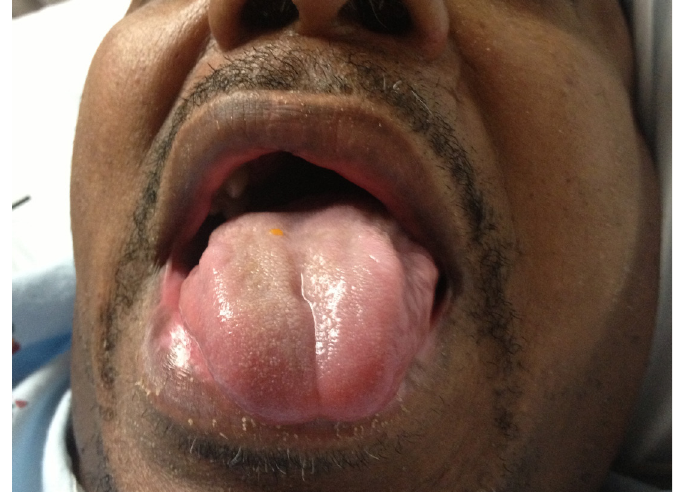
Figure 1 . Hemi orolingual swelling after tissue plasminogen activator infusion.